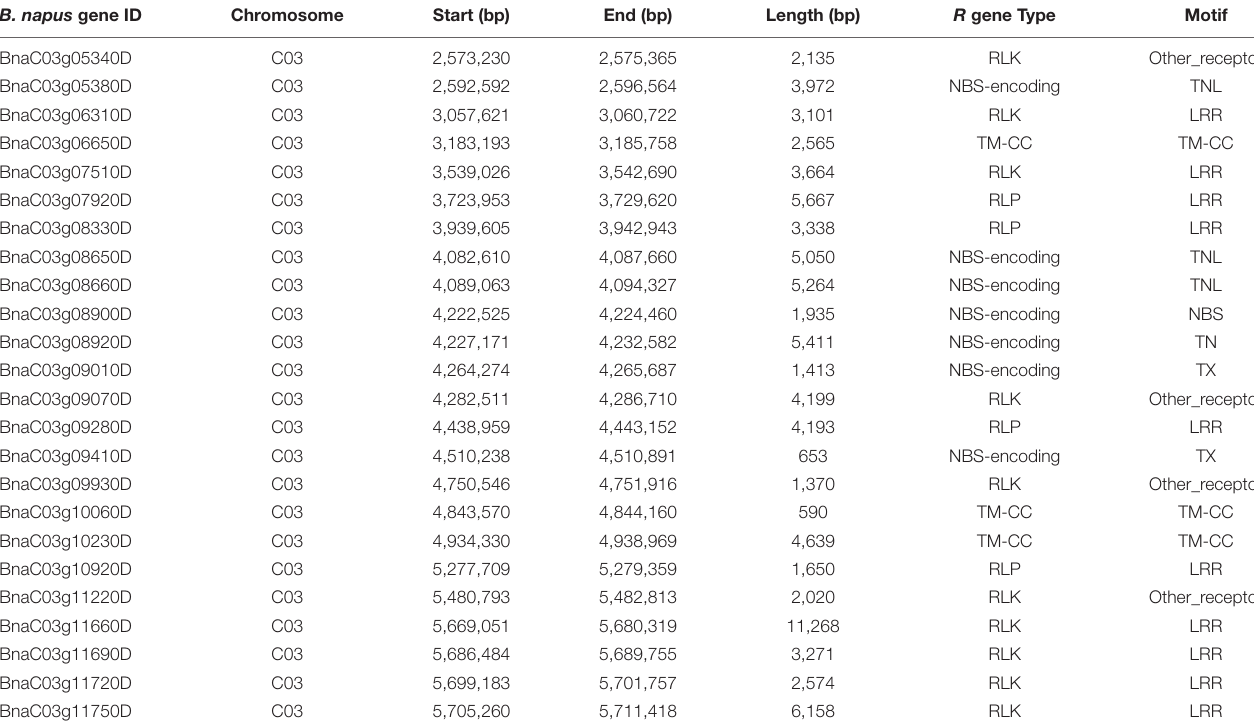
TABLE 3 | Candidate genes identified in the vicinity of the Rlm13 genomic region associated with resistance to L. maculans , causing blackleg disease in canola ( B. napus L.). B. napus gene ID